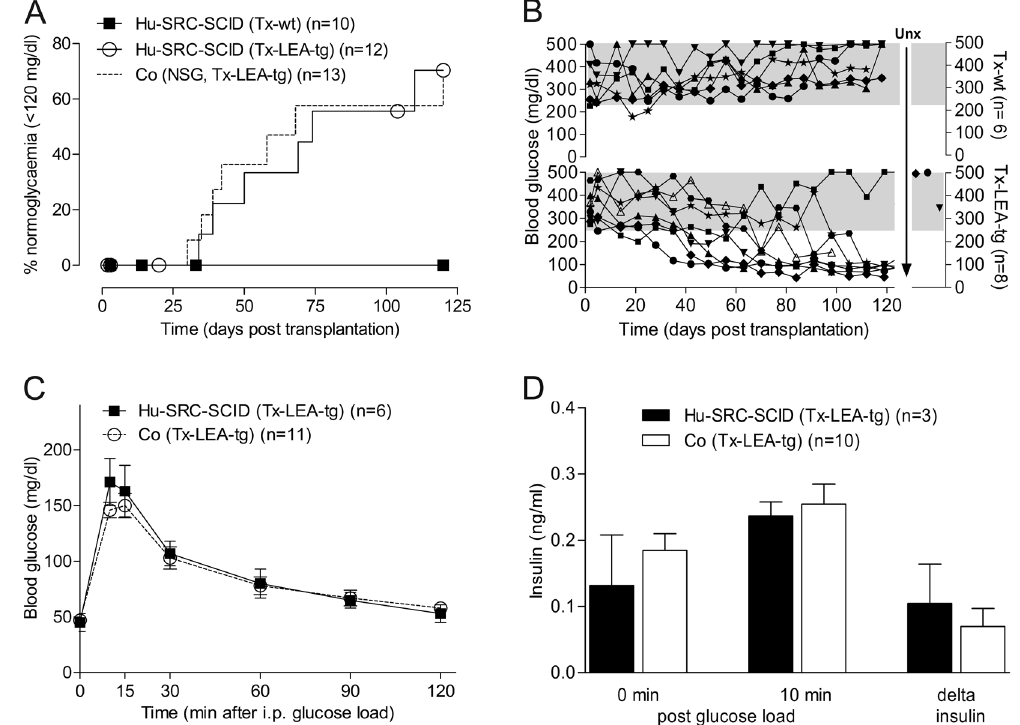
Figure 2. Transplantation of LEA29Y-tg neonatal porcine islet-like clusters (NPICCs) into diabetic NSG mice carrying a human immune system (HU-SRC-SCID). ( A ) Development of normoglycemia (random blood glucose levels consistently < 120 mg/dl), blood glucose ( C ) response and insulin secretion ( D ) during intraperitoneal glucose tolerance testing was comparable in humanized Tx-LEA-tg and immunodeficient NSG mice transplanted with equivalent numbers of NPICCs. The 125-day time course of mice with LEA-tg NPICCs shows normalization of blood glucose levels in n = 5 mice, near normal glucose levels in n = 2 animals, and persistent hyperglycemia in n = 1 mouse ( B ). In contrast, all Tx-wt remained hyperglycemic (Log-rank test p = 0.039) ( A , B ). N = number of animals examined per